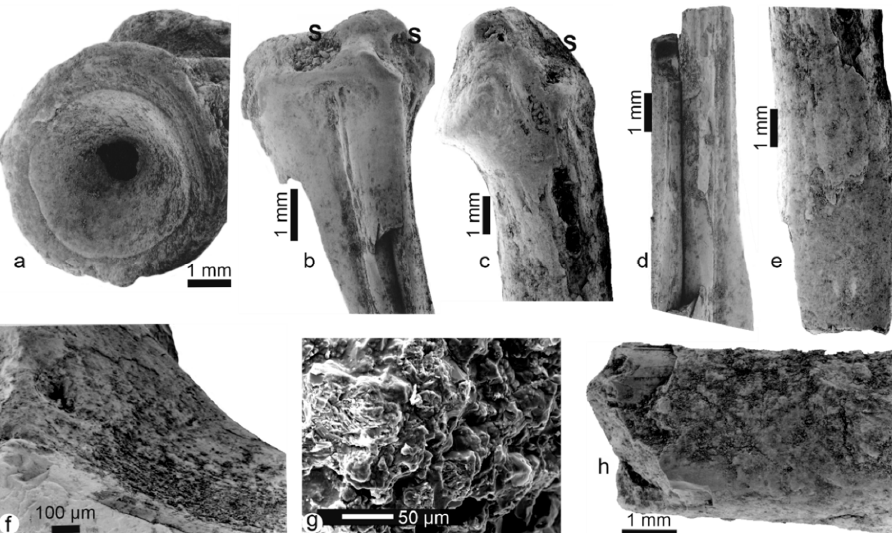
Figure 4. Malema fossil bones. ( a ) Centrum of a vertebrae showing rounding and desquamation and perforated centre. ( b , d ) Spines displaying very light digestion (polishing and small holes) on articular zones accompanied by desquamation. ( c ) Spine showing polishing and holes of light digestion on the articular extremity. ( e ) Spine fragment displaying old breakage, rounding and desquamation. ( f ) Alteration of the bone structure near an articular extremity of the spine, the outer layers being destroyed. ( g ) Surface of a broken bone showing a strongly modified structure, cleaned using an ultrasonic bath and H 2 O. ( h ) Desquamation on a broken bone. S: sediment.